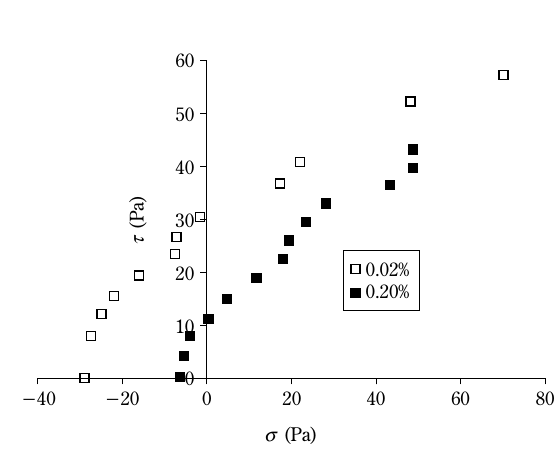
Fig. 19 Yield locus of experimental toners (12.7 µ m particle size, 0.02% and 0.2% by weight of Aerosil) determined by the tilted fluidized bed